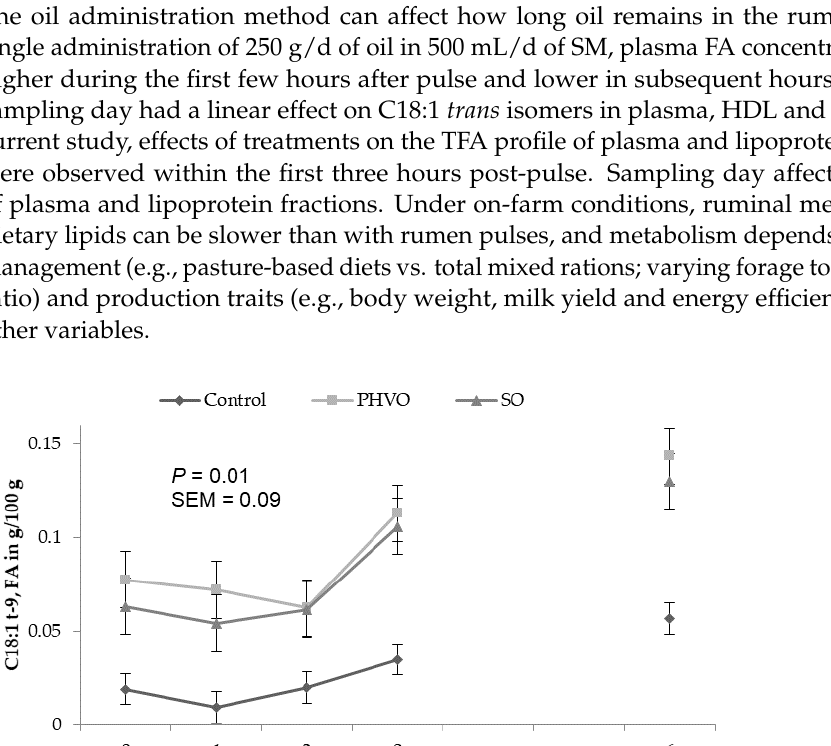
Figure 4. Time variations of C18:1t ‐ 9 in high density lipoprotein from cows subjected to ruminal pulses of control, partially hydrogenated vegetable oil and soybean oil. Blood samples were col ‐ lected prior to ruminal pulse (0 h; 09:00) and 1, 2, 3 and 6 h after ruminal pulse. SEM = standard error of the mean. Means are pooled across days for each cow. p ‐ value represents the effect of sam ‐ pling time.